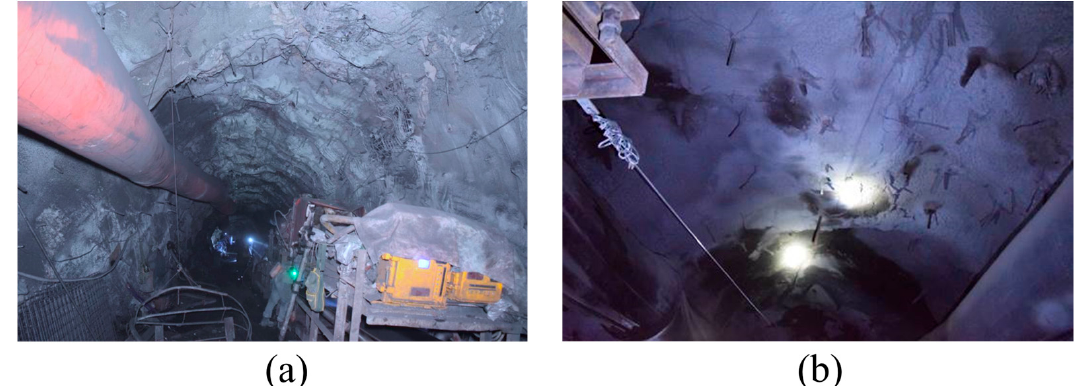
Figure 3. The e ff ect of roadway maintenance under original support: ( a ) location I; ( b ) location II.